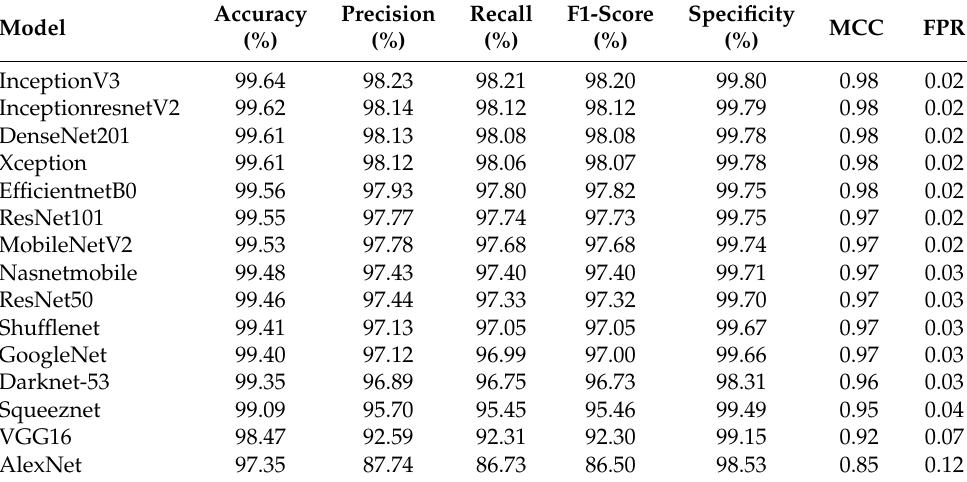
Table 10. Average performances of the Transfer learning Models.